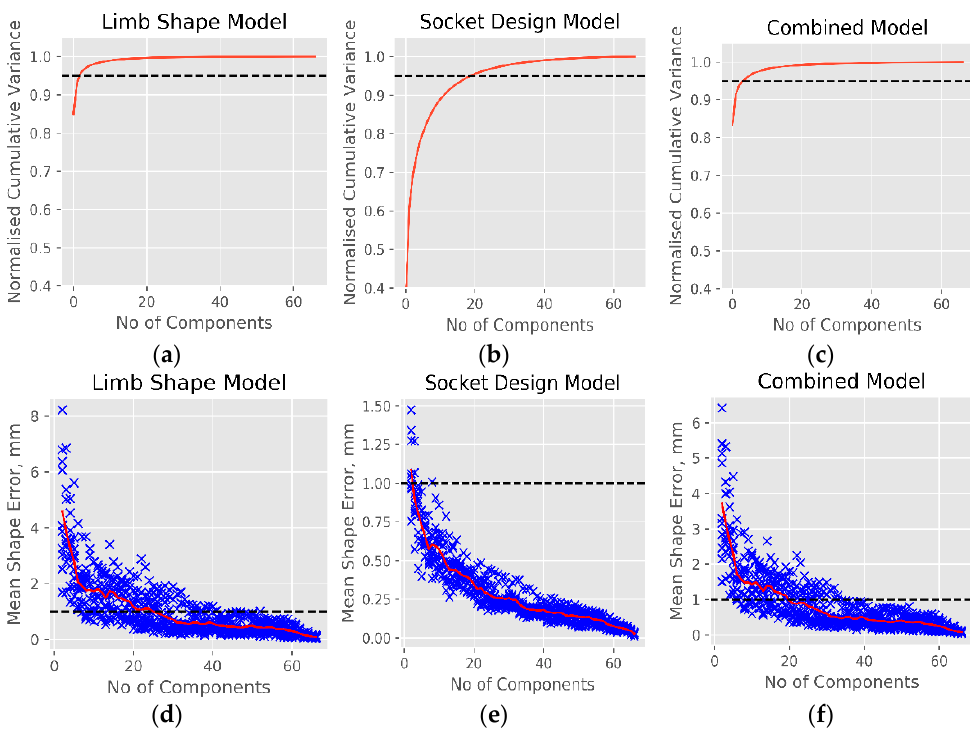
Figure 4. Cumulative mode variance graphs ( a ‒ c ) and leave-one-out (LOO) error graphs ( d ‒ e ) for statistical limb shape model (SLM, a , d ), statistical socket design model (SDM, b , e ) and statistical limb shape and socket design model (SLDM, c , f ) cases.